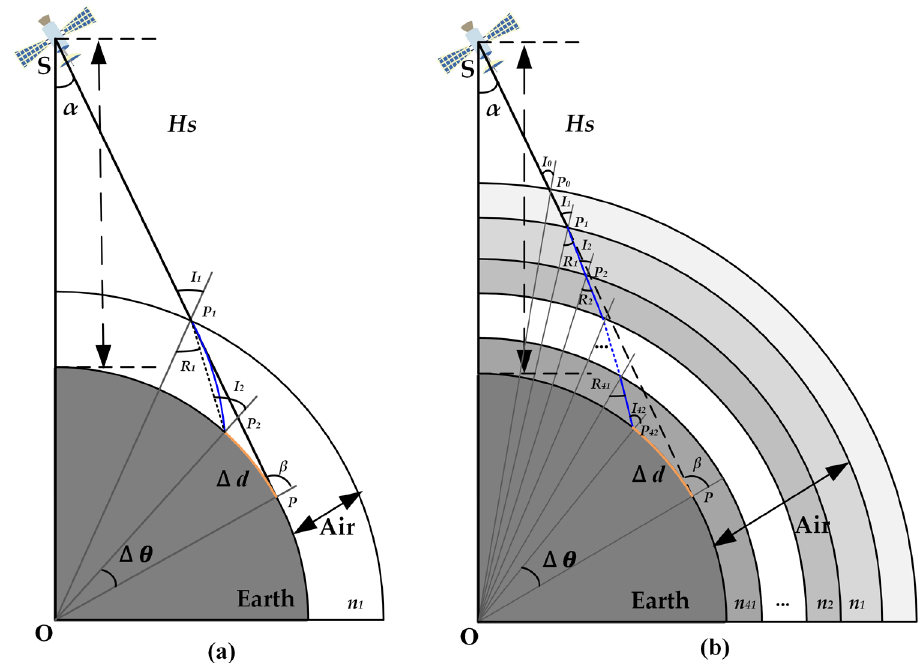
Figure 1. Schematic of the atmospheric refraction error. ( a ) Atmospheric refraction error of the single-layer model. α is the off-nadir angle, β is the viewing zenith angle, Hs is the satellite’s orbital altitude, ∆ d is the atmospheric refraction error, and n 1 is the refractive index of the atmosphere in the model. ( b ) Atmospheric refraction error of the proposed model. The atmospheric refractive index value varies with time and space.